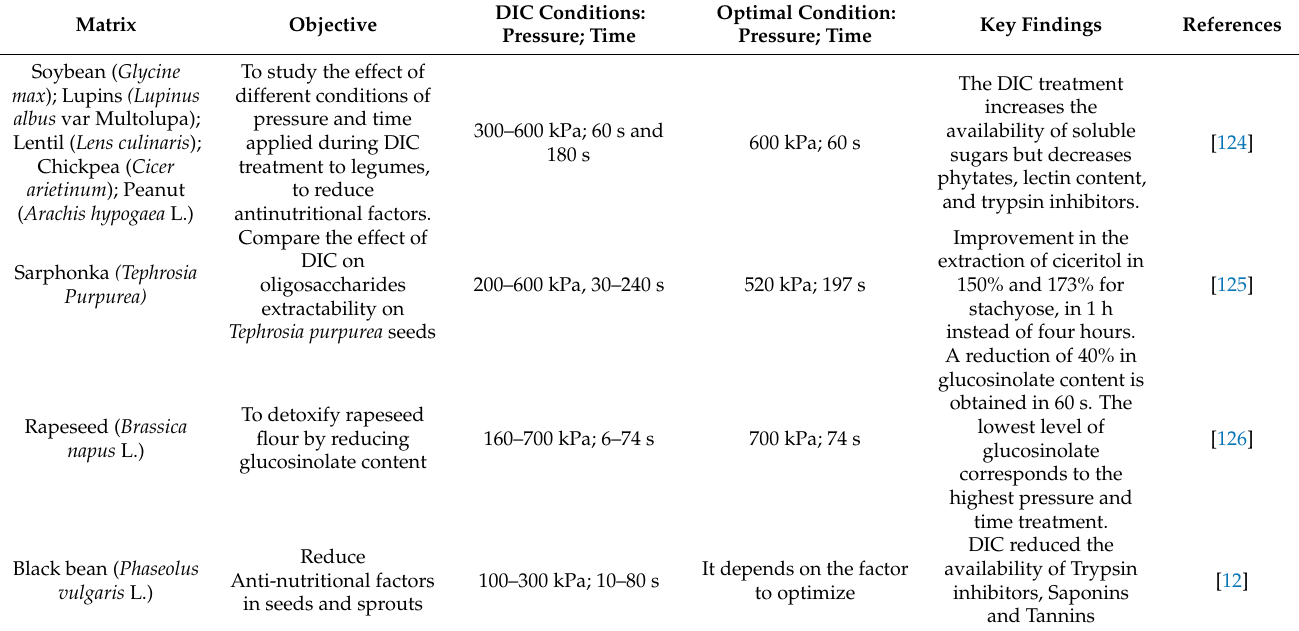
Table 10. Evaluation of DIC treatment on the content of non-nutritional factors in legumes. Matrix Key